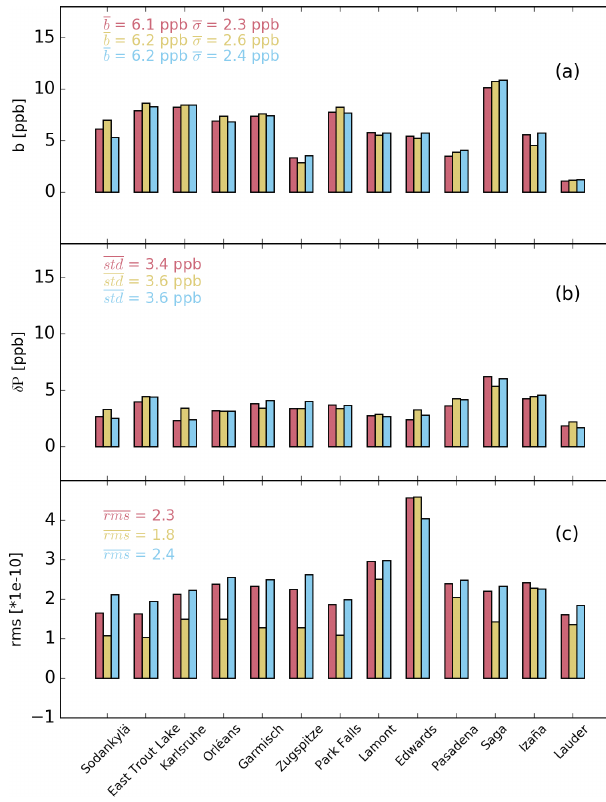
Figure 4. The same as Fig. 3 but deploying the spectroscopic database used in the operational TROPOMI CO processing (HI- TRAN 2008 with H 2 O